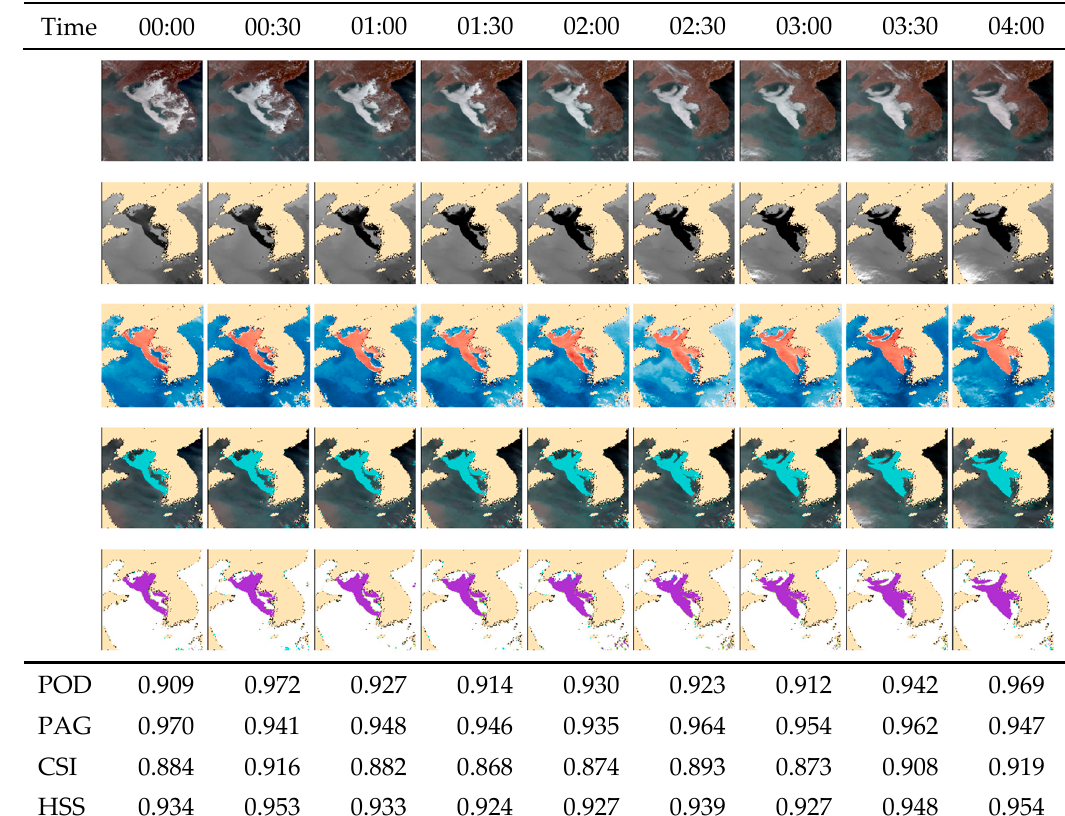
Figure 11. Temporal variation of sea fog on 26 March 2019, from 00:00 UTC to 04:00 UTC with 30-min intervals in an RGB image, the brightness temperature at 3.9 µ m, NDSI dif f results for sea fog detection, and the statistical comparison between two sea fog algorithms.